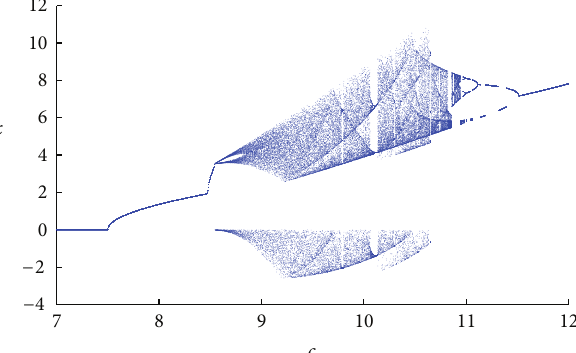
Figure 8: Bifurcation diagram of the system with respect to 𝑐